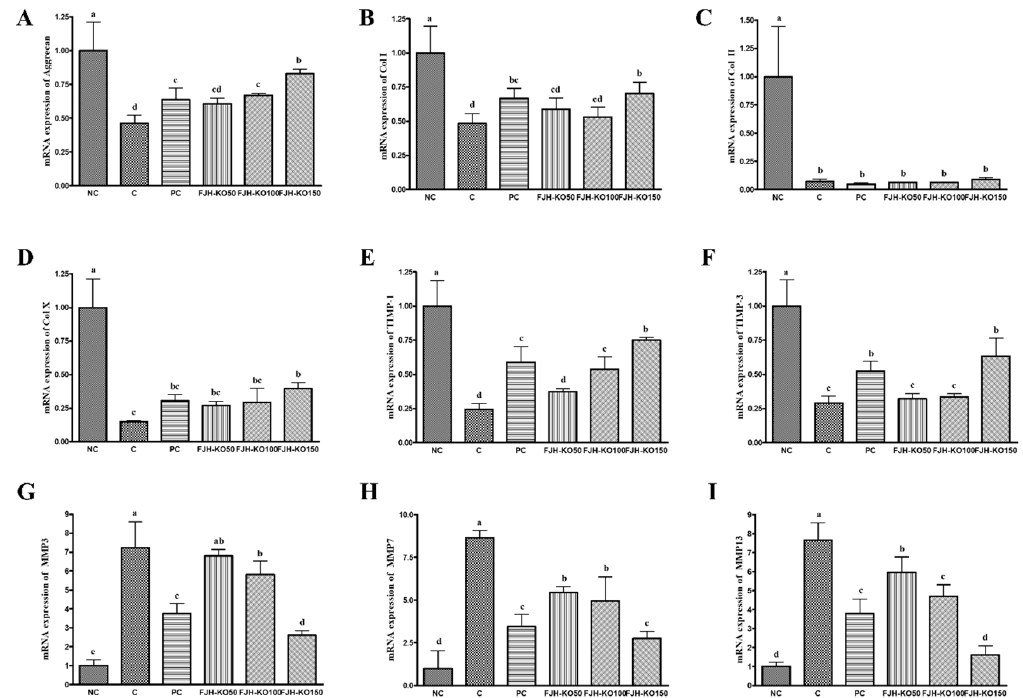
Figure 4 . Effect of krill oil on mRNA expression of anabolic factors and catablic factors in rat model with or without induced osteoarthritis by MIA. ( A ) aggrecan, ( B ) Collagen type I, ( C ) Collagen type